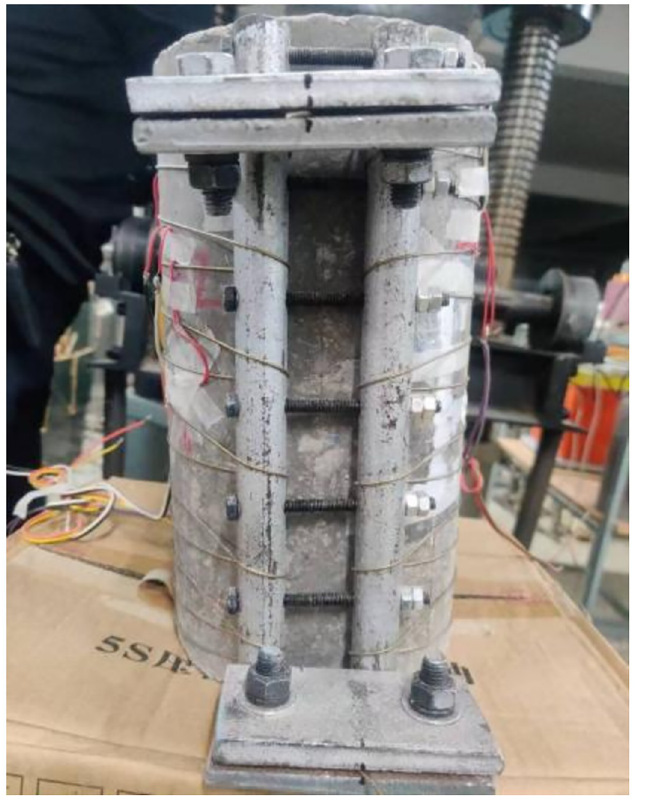
Fig 3. SMA wire reinforced